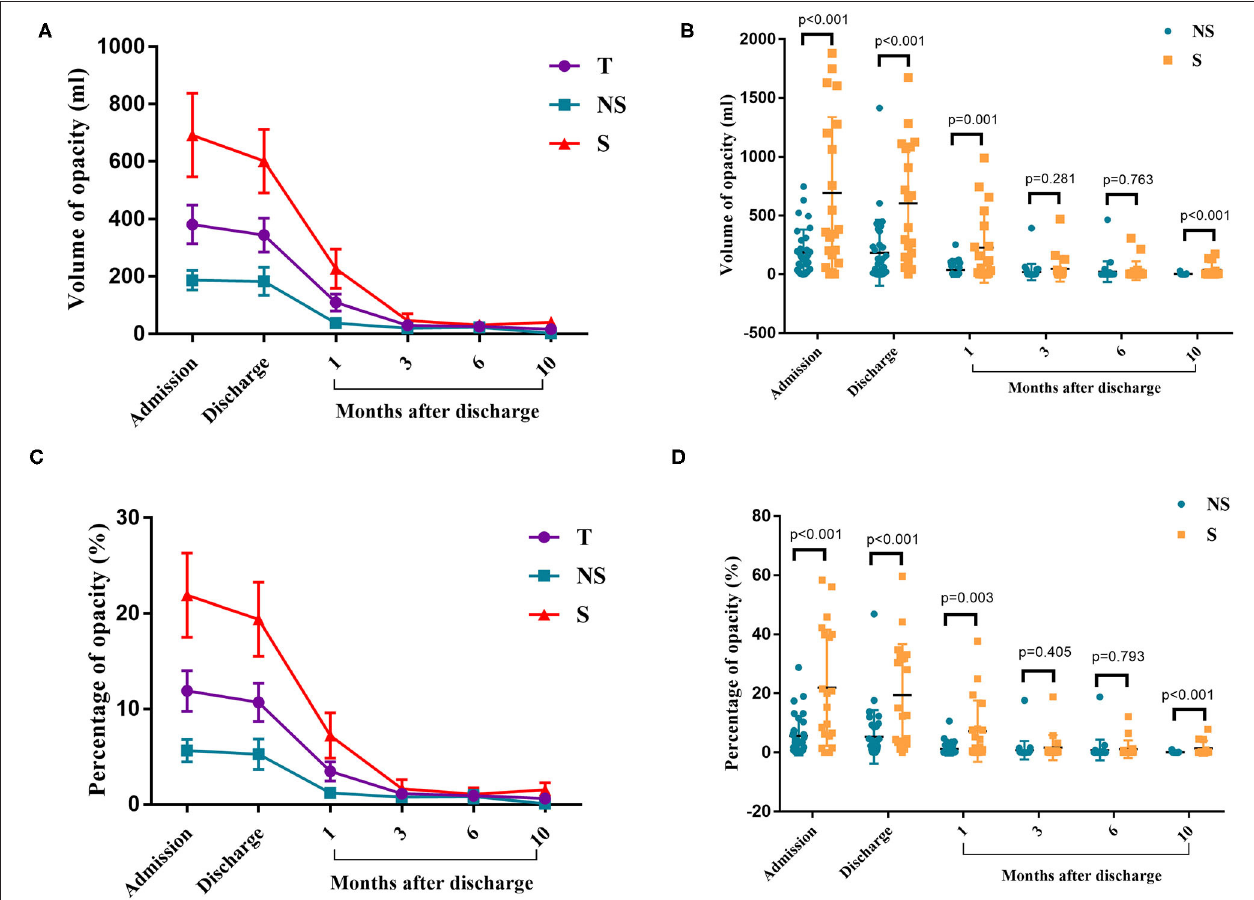
FIGURE 2 | Chest CT results. (A) The changes in the volume of opacity for each time point. (B) Volume of opacity in the severe and non-severe groups. (C) The changes in the percentage of opacity for each time point. (D) The percentage of opacity in the severe and non-severe groups. T, total; NS, non-severe; S,